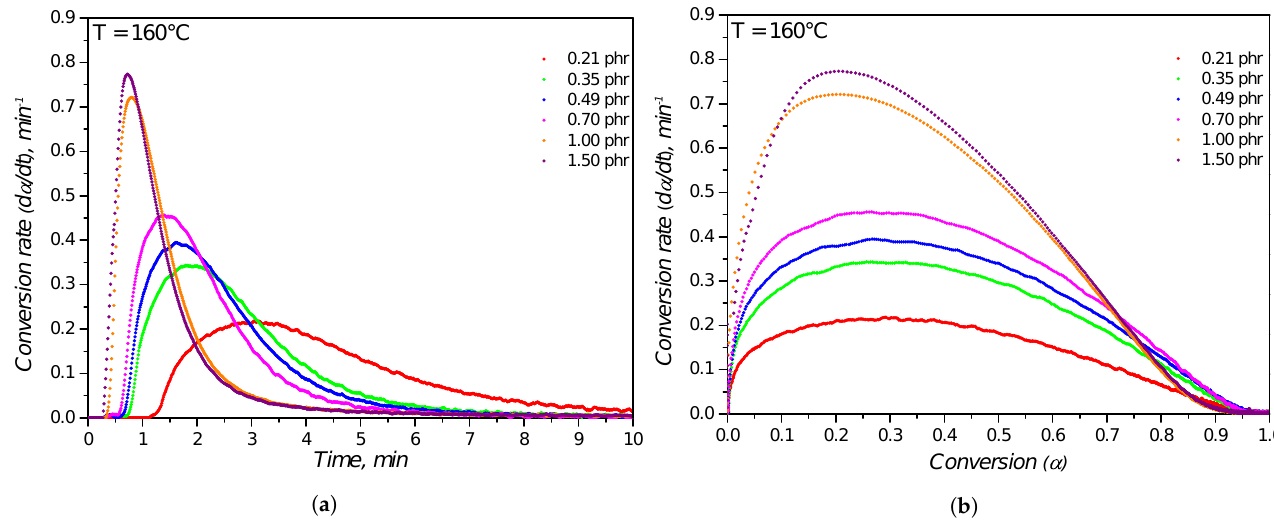
Figure 3. Conversion rate d α at 160 ◦ C for silicone rubber compounds with different dicumylperoxide dt concentrations as a function of time ( a ) and conversion ( b